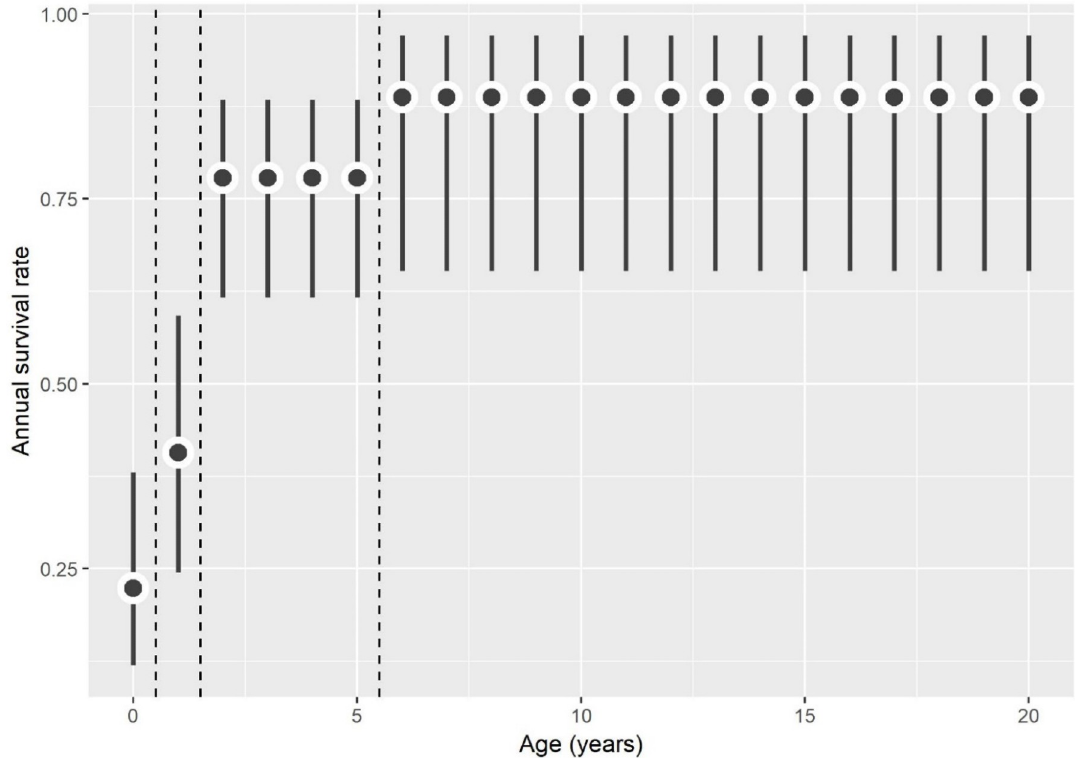
Fig 8. Annual survival rates of American crocodiles ( Crocodylus acutus ) captured in South Florida as a function of age. Dots represent mean values and error bars indicate 95% confidence intervals, dashed lines are age groups demonstrating similar survival rates (0–1 yr old, 1–2 yr old, 3–6 yr old, 7–22 yr old).